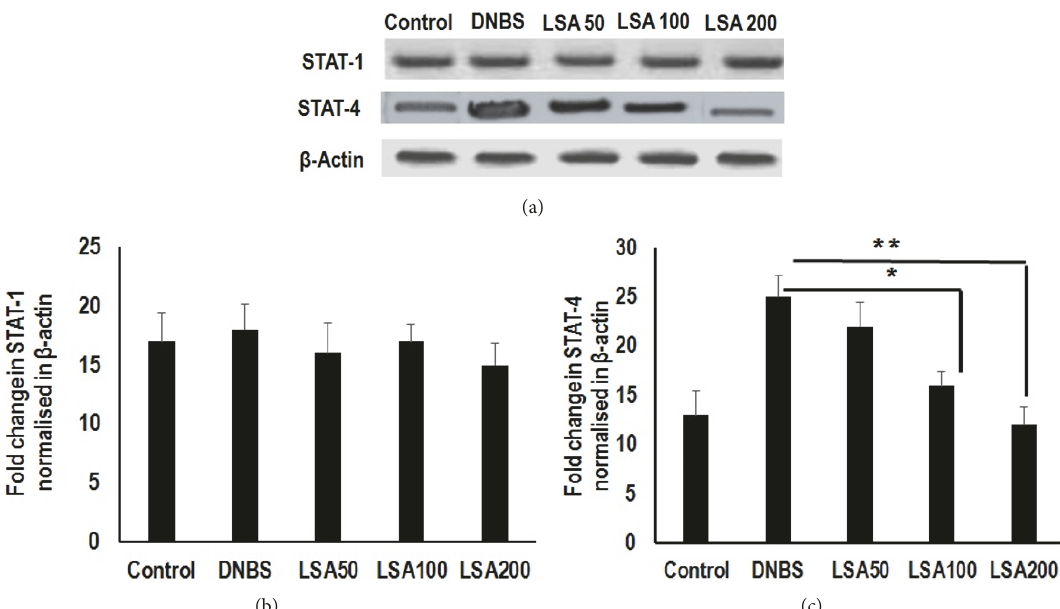
Figure 6: The mRNA expression of STAT-1 and STAT-4. Agarose gel electrophoresis was used for semiquantitative determination of PCR- amplified transcription factor of mRNA in colons; total RNA was extracted and was reverse-transcribed to cDNA. Amplification was performed by gene-specific primers with 2 𝜇 L cDNA for 25 cycles ( 𝛽 -actin) or 35 cycles (transcription factor). (b) The fold change in STAT-1 mRNA (normalized to 𝛽 -actin) expression in colon. (c) The fold change in STAT-4 mRNA (normalized to 𝛽 -actin) expression in colon. The PCR band density is automatically generated by the ImageJ software. Results shown are mean ± SD, with n=4 replicates in each group. ∗ p < 0.05. ∗∗ p < 0.001 (ns: not